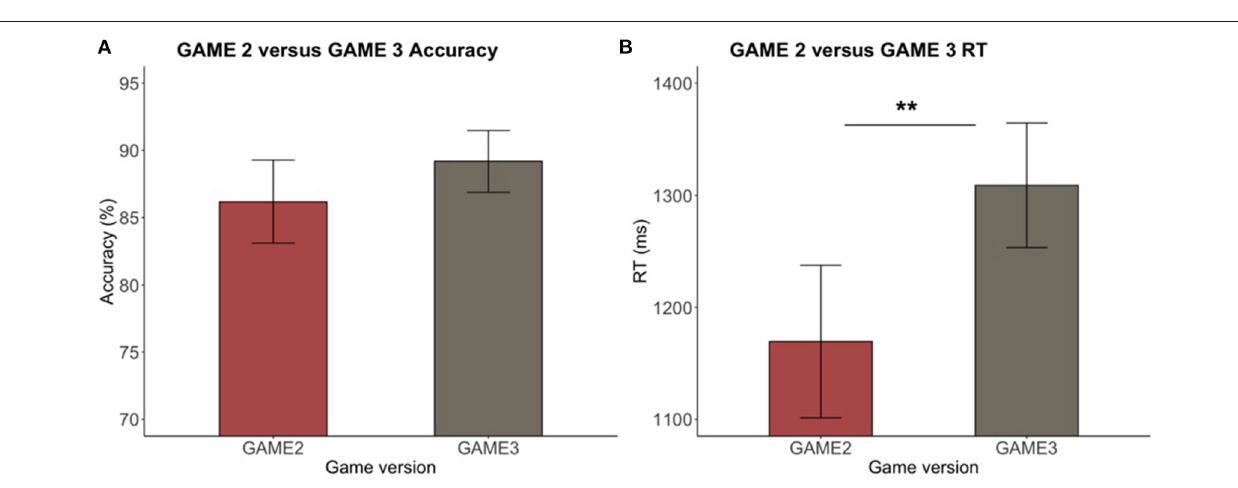
FIGURE 9 | (A,B) Game version 2 vs. game version 3 accuracy and RT. No significant difference was found in accuracy while a significant difference was found in RT between versions (** p < 0.01; error bar = 95%